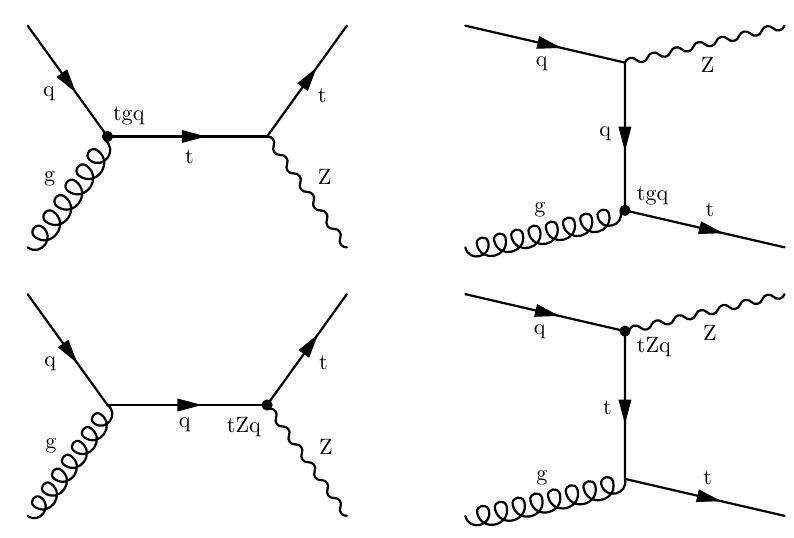
Figure 2 . Feynman diagrams for the production of tZ in tZ-FCNC channels.